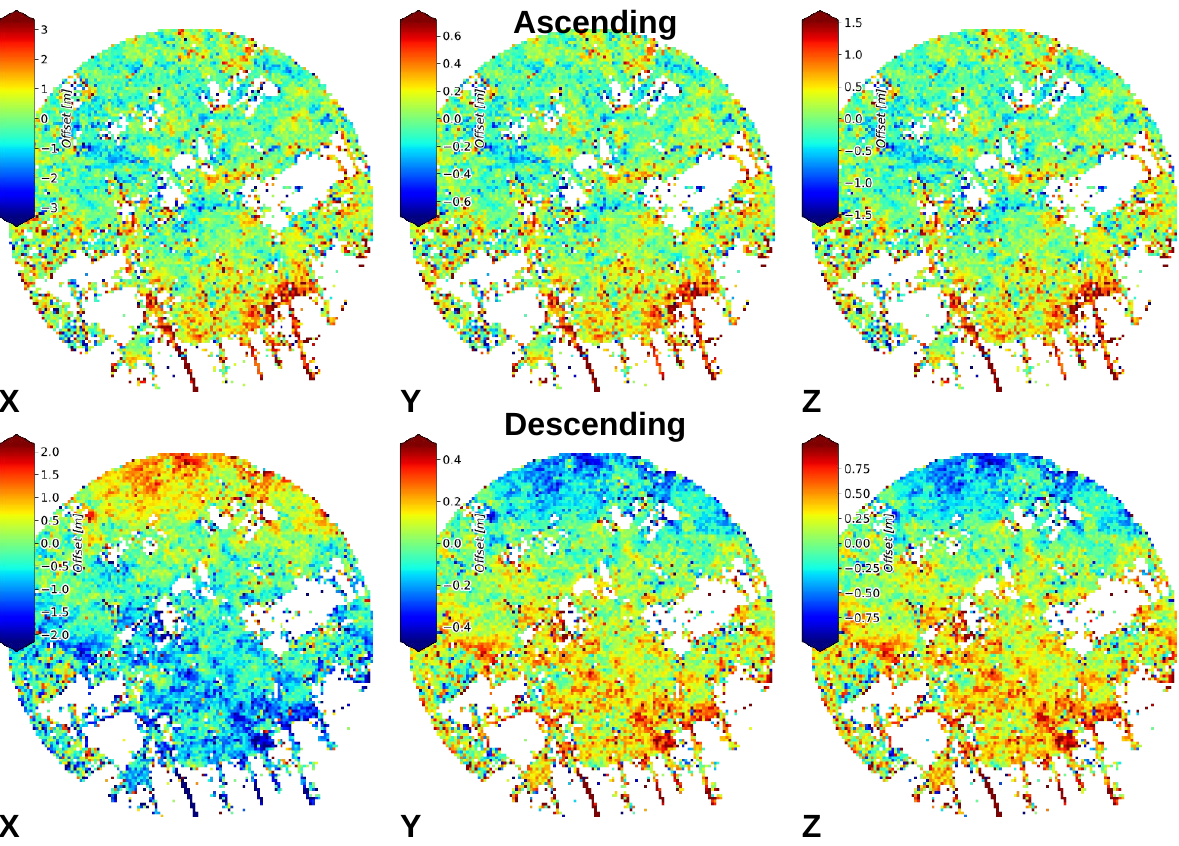
Figure 11. Regional trends ( 100 × 100 m median) in the offset between the geolocation estimation and the Nearest Neighbour (NN - est.) for both ascending and descending